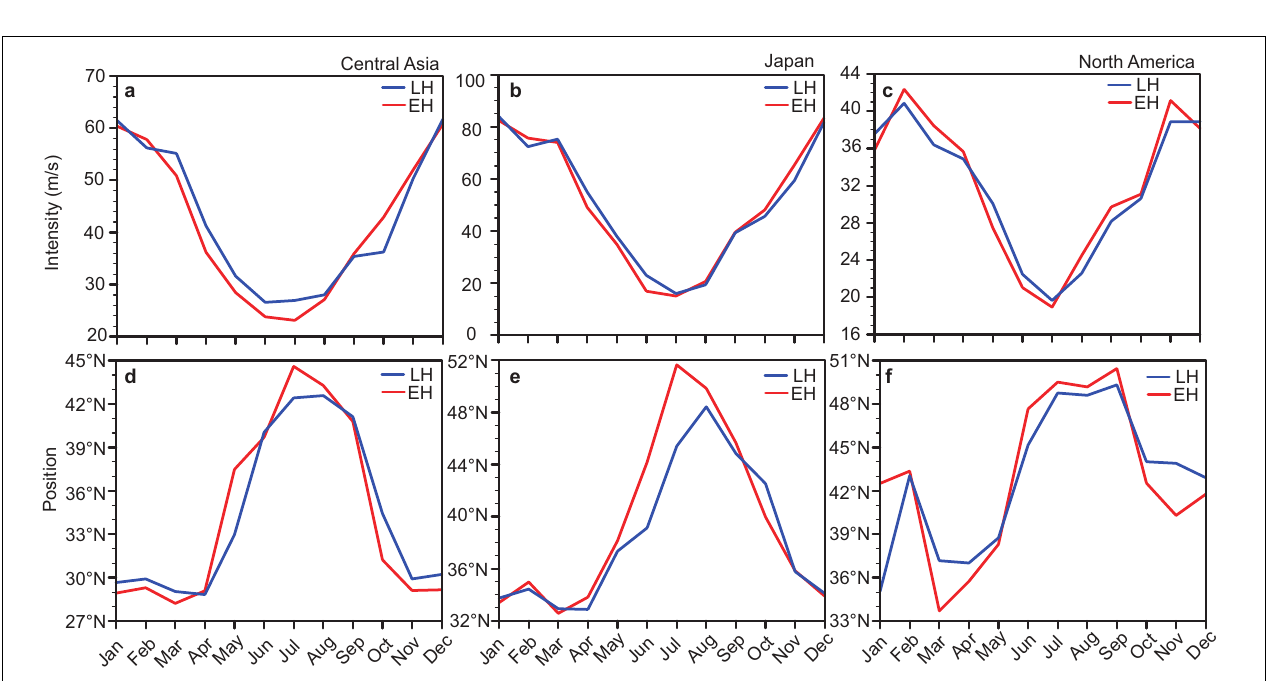
FIGURE 6 | Monthly variation of intensity and position of WJ over Central Asia (a,d) , Japan (b,e) , and North America (c,f) . The red and blue lines represent the EH and LH, respectively.